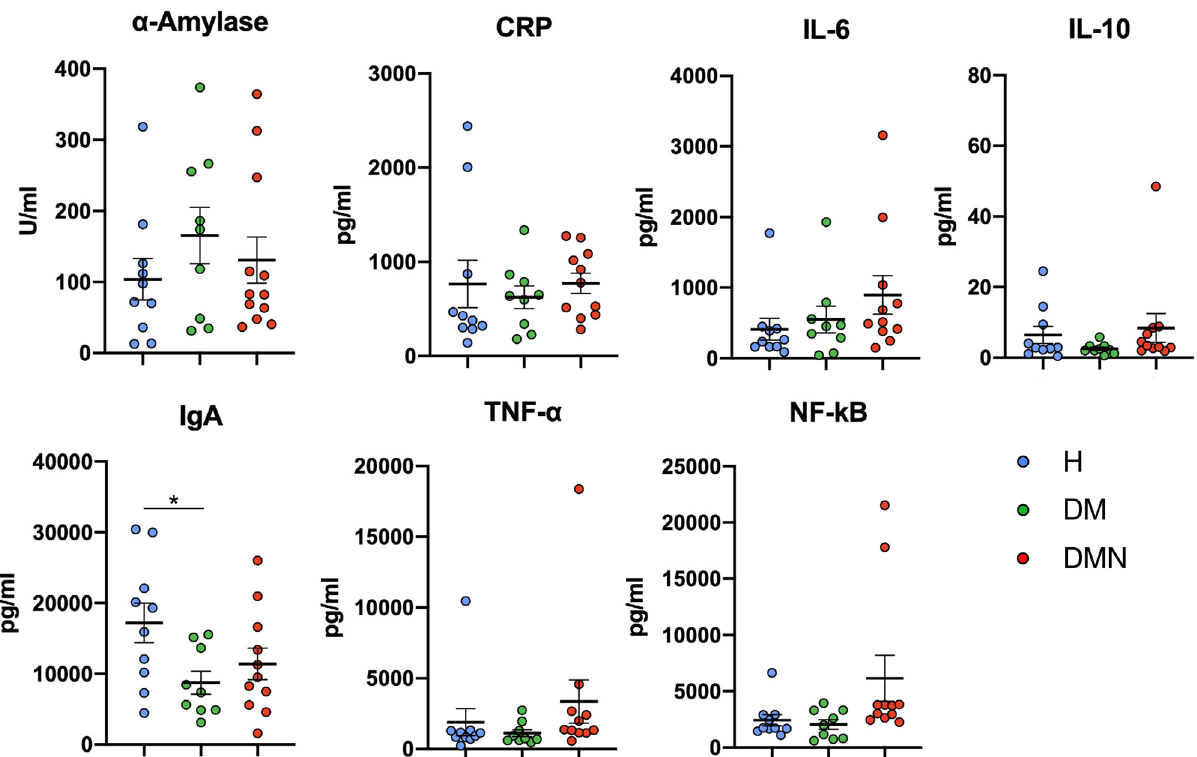
Figure 2. Biomarker levels in saliva among the groups. Mean ± SEM. One-way ANOVA and Tukey were performed. *p <